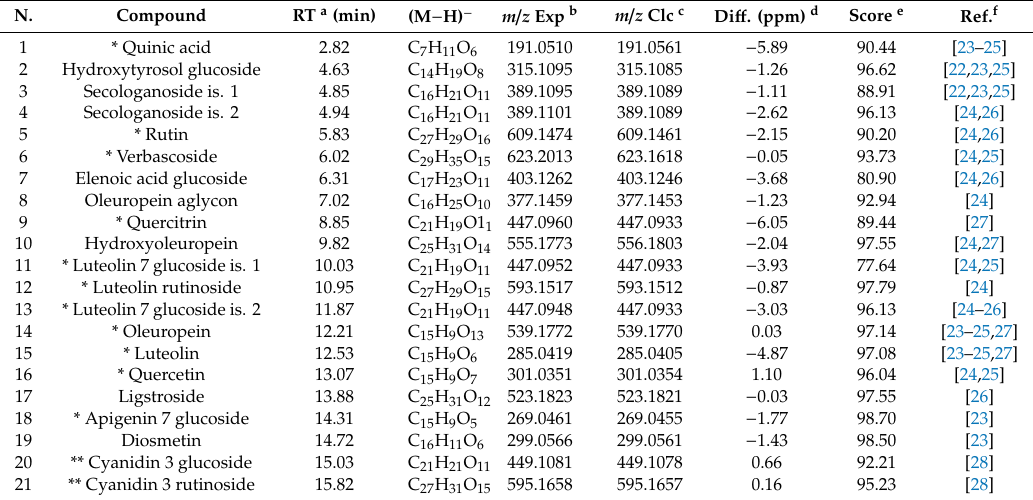
Figure 3. Total phenolic contents (mg GAE/g DW) in seven commercial black table olives. Results are expressed as mg of gallic acid equivalent (GAE)/g dried olive pulp. Same letters indicate no statistical differences between averages (Duncan test, n = 3, p = 0.05). Table 1. List of chemicalss and anthocyanins putatively identified by High-Performance Liquid Chromatography coupled to Electrospray Ionization Time-of-Flight Mass Spectrometry (HPLC ESI/MS-TOF) following extraction from CdN olive pulp at different stages of maturation. N.